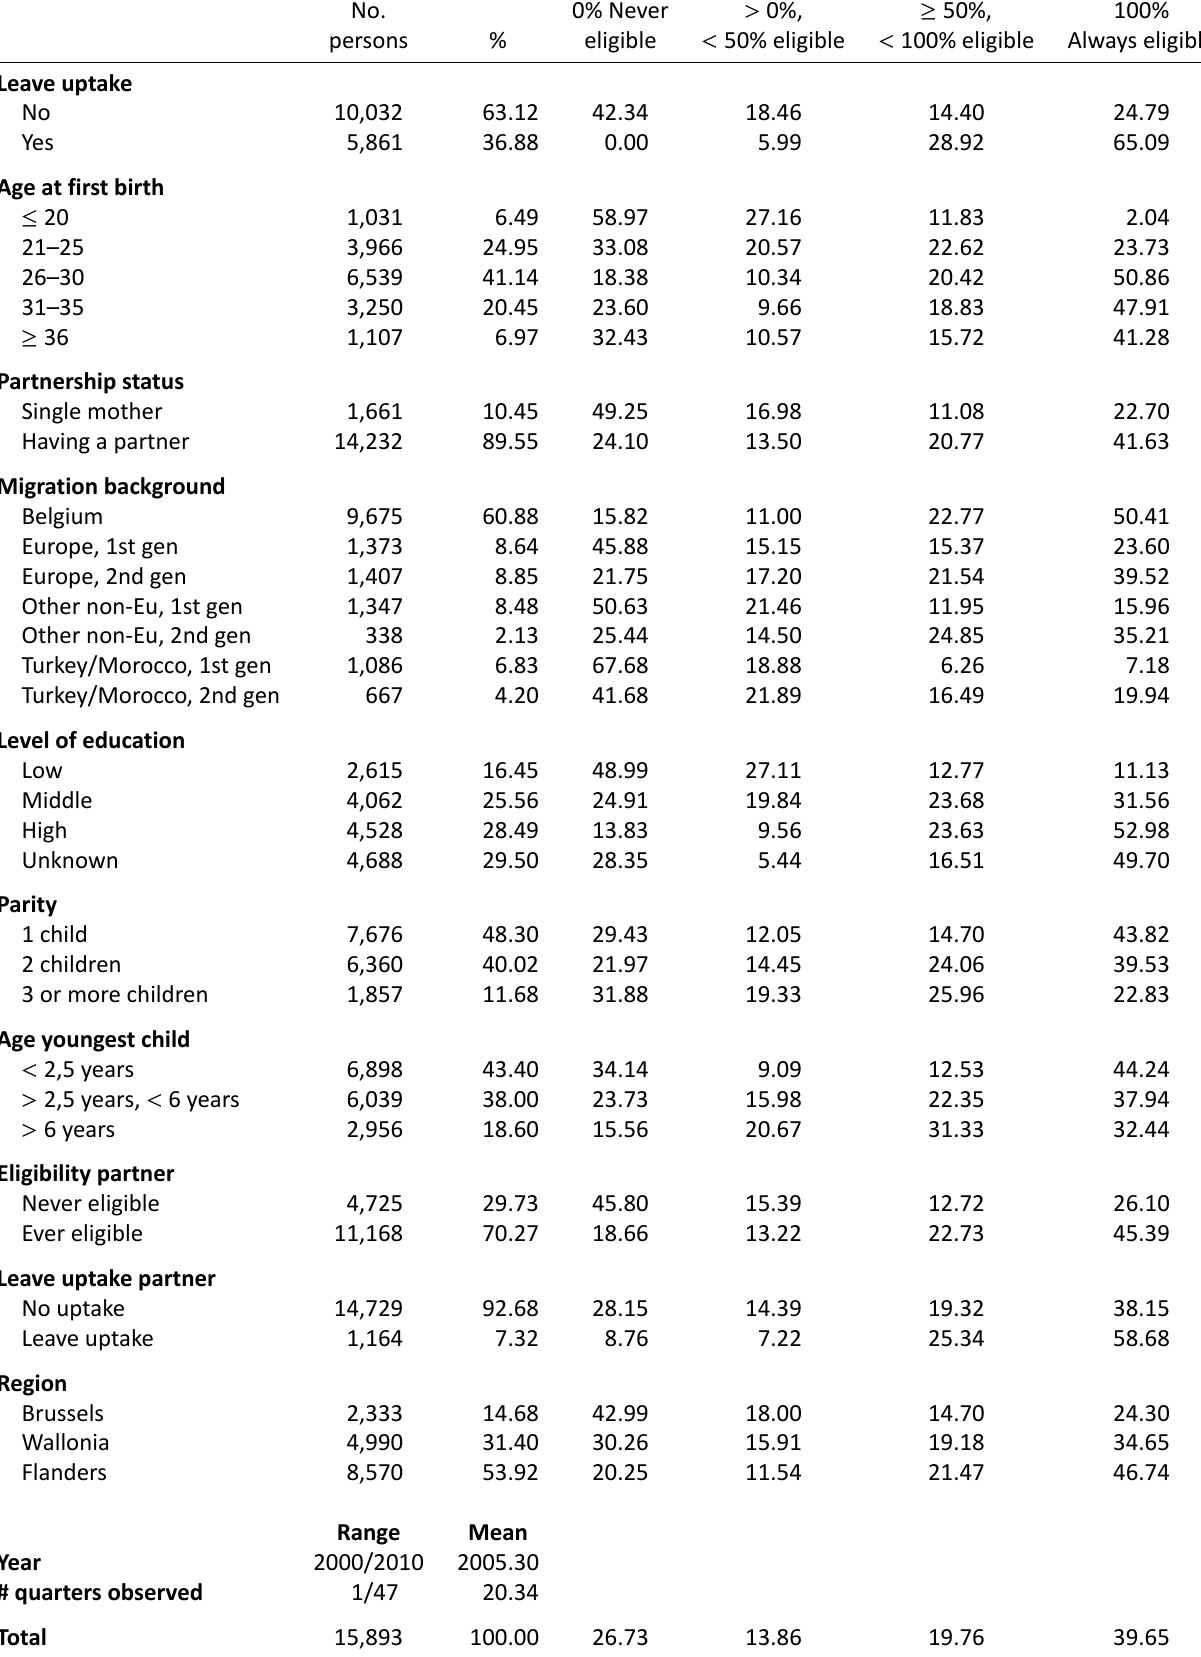
Table 1. Summary statistics and the distribution of the eligibility indicator by all